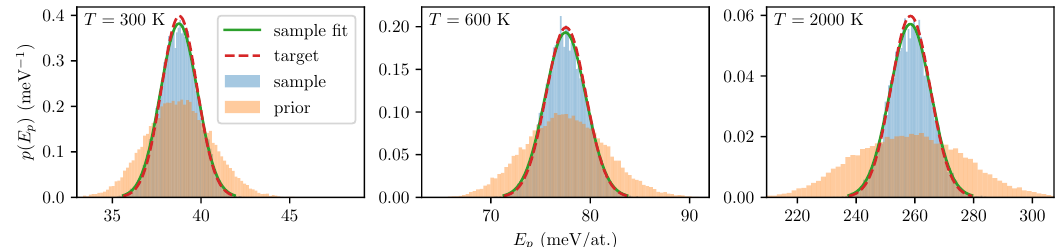
Figure 3: Prior energy probability distribution (orange filling) versus target distri- bution (blue filling). The lines indicate target distribution (red dashed line) and Gaussian distribution fitted to generated sample (green solid line). The data was generated for temperatures T = 300, 600 and 2000 K with δ = 0.1 in HECSS proce- dure (see description in the